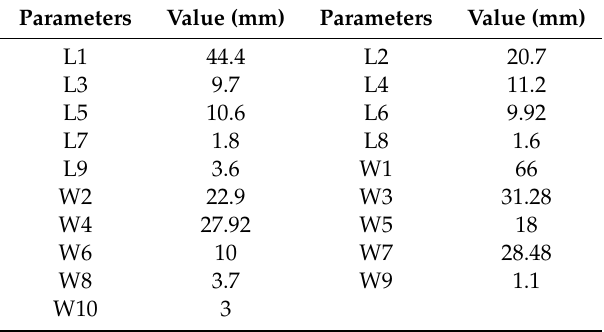
Figure 1. Geometry of proposed BRA: ( a ) top view of BRA; ( b ) the view of the high impedance stub (HIS). Table 1. Dimensions of proposed BRA.